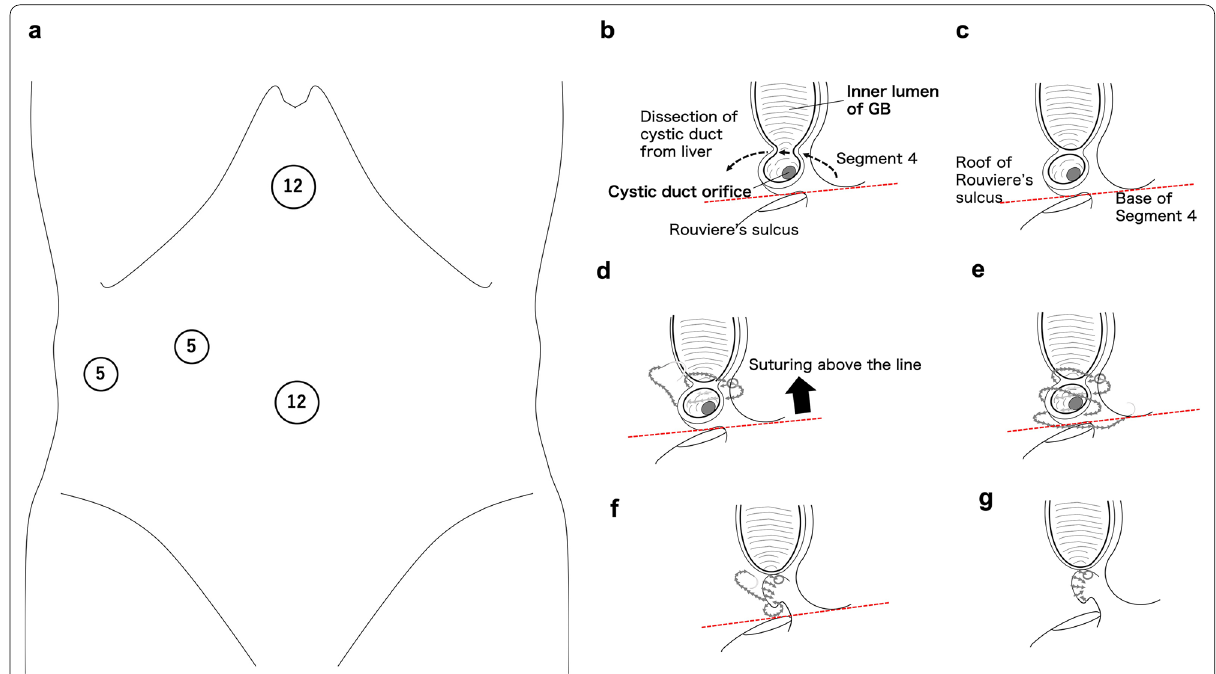
Fig. 1 Port placement for LSC and surgical procedures of LSC. a The scopist used the umbilical port and main surgeon stood left side of patient. b Making incision on the GB and identification of cystic duct orifice from the inner lumen of GB leaving a part of GB wall on the liver bed. Dissection of cystic duct from the liver. c Isolation of cystic duct and identification of the line between the base of Segment 4 and the roof of Rouviere’s sulcus. d – g Suture using an absorbable 3-0 V-Loc above the